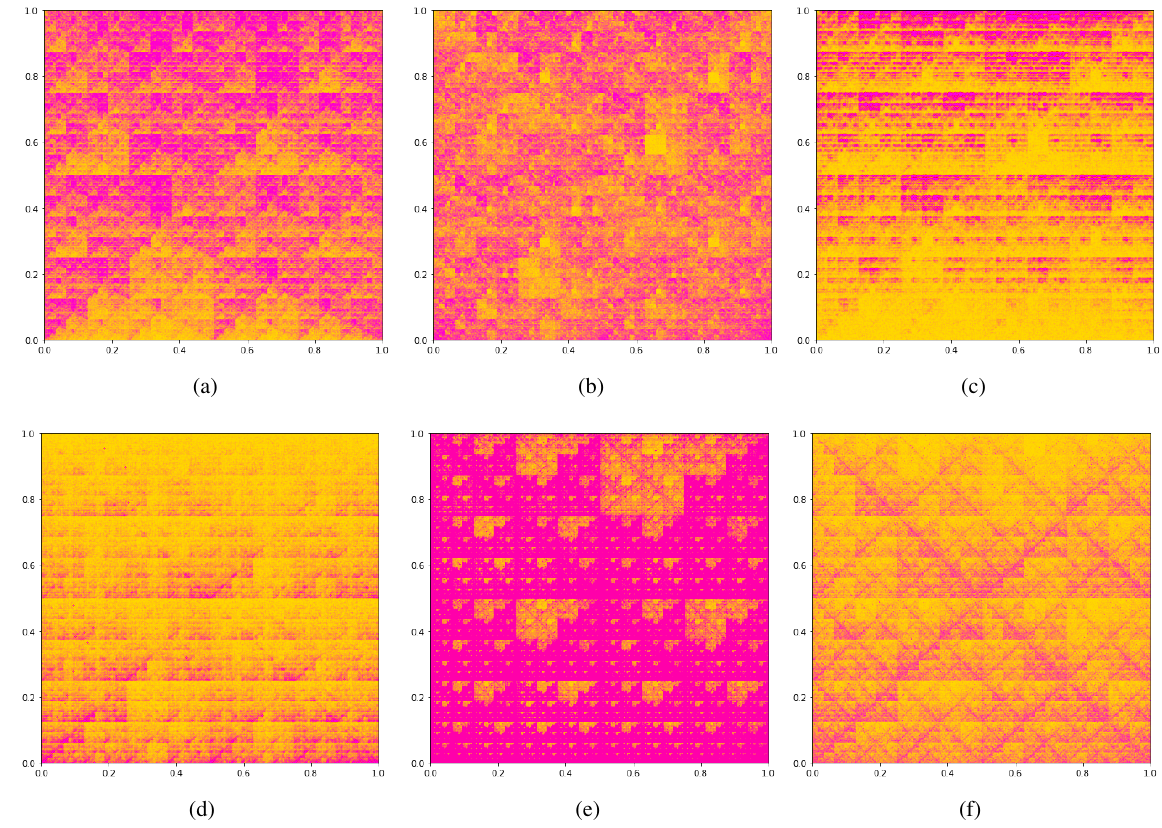
Fig. 1 The CGR of two bacterias ( Pirellula staleyi and Escherichia coli ), two archaea ( Nanoarchaeota archaeon and Halobacterium salinarum ), the Homo sapiens chromosome 21 and a fungus Encephalitozoon intestinalis